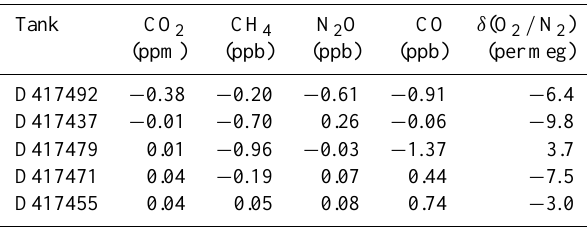
Table 4. Target tank biases (mean of NDAO target measurements – assigned value from MPI-BGC).